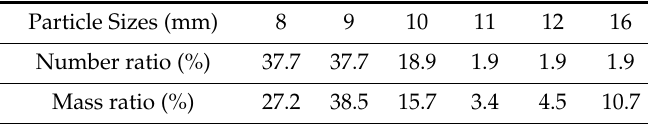
Table 2. Sizes and their mass ratios of coal particles.